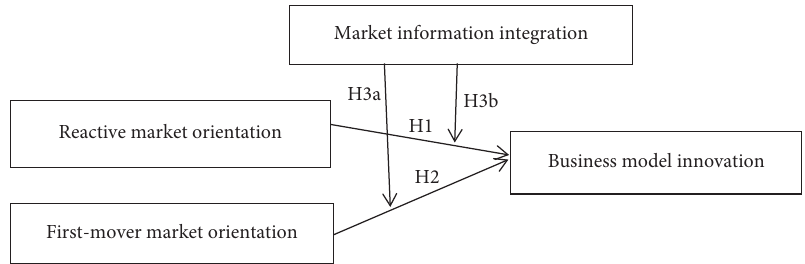
Figure 1: Research framework model